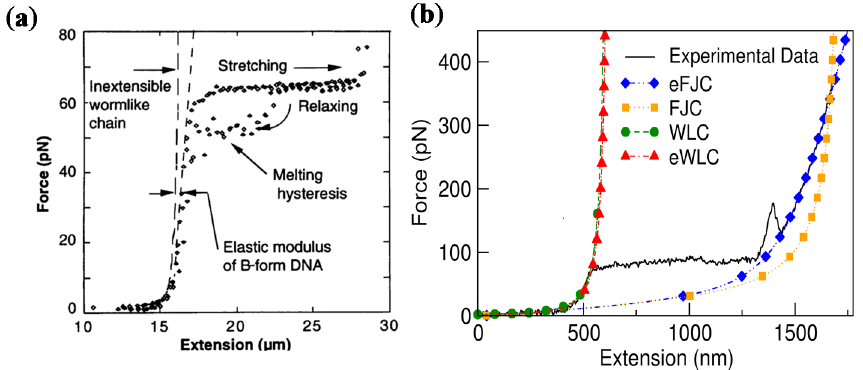
Figure 3. Experimental force-extension data for the stretching of λ -phage DNA. ( a ) The data are obtained from optical tweezers and fitted with the WLC model. Adapted from [1]. Reprinted with permission from AAAS; ( b ) Data are obtained from AFM single molecule